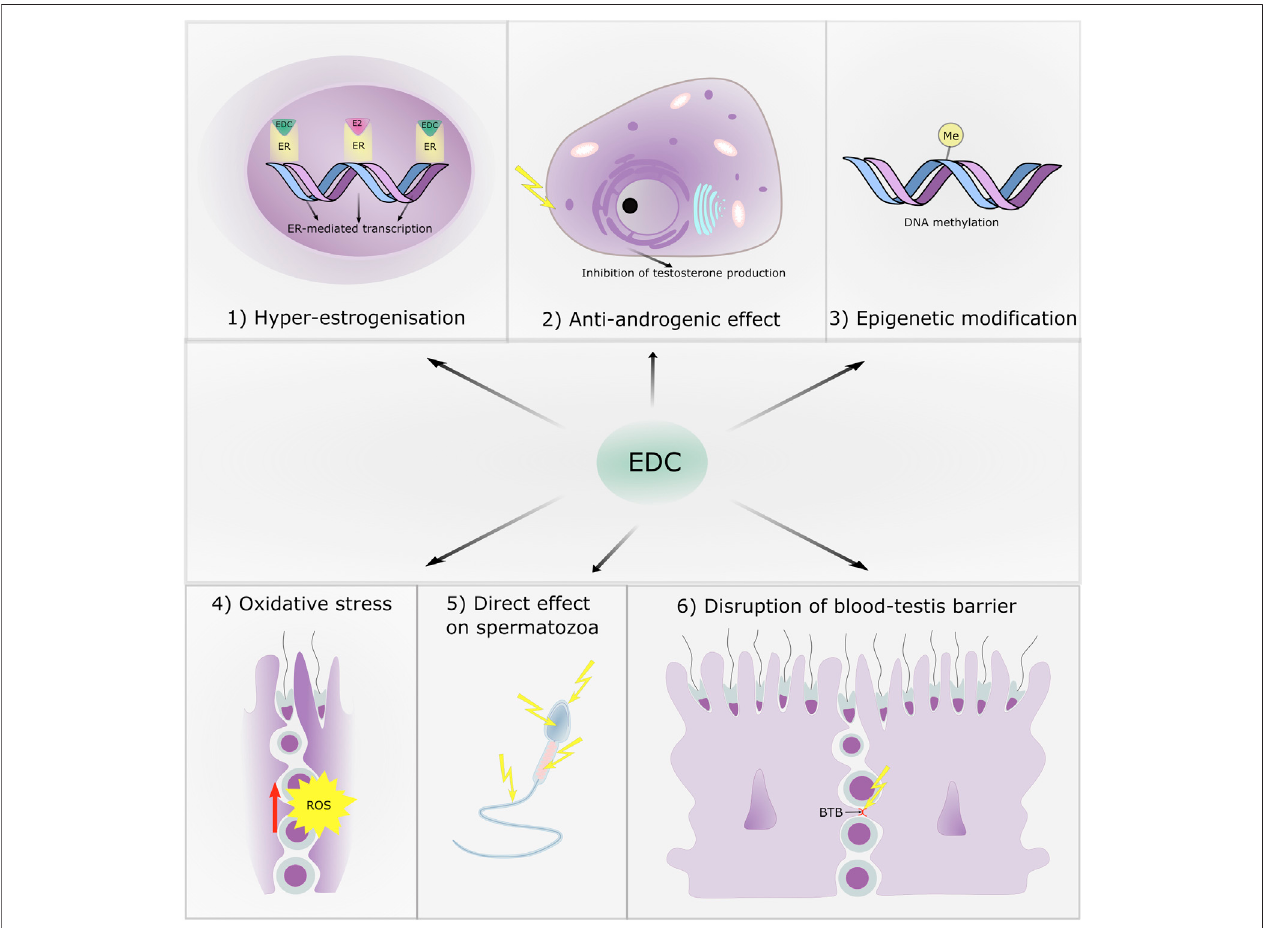
FIGURE 2 | The main targets of endocrine disruptive chemicals with respect to male